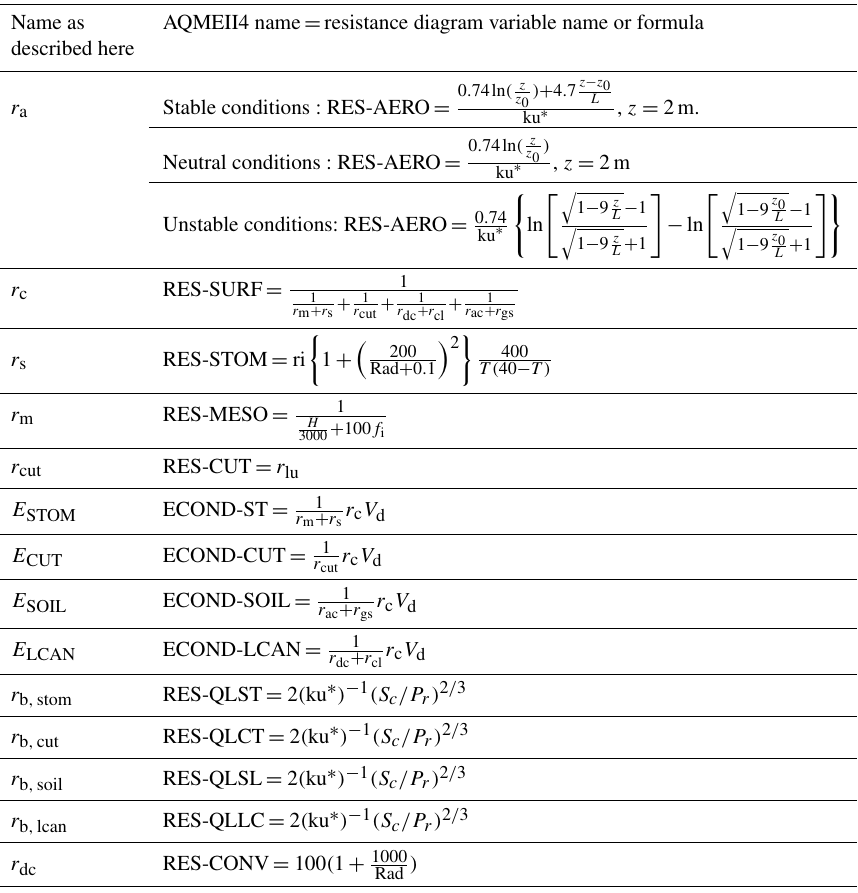
Table B6. AQMEII4-reported gaseous deposition variables corresponding to the WRF-Chem resistance model of Fig. B6. Name as AQMEII4 name = resistance diagram variable name or formula